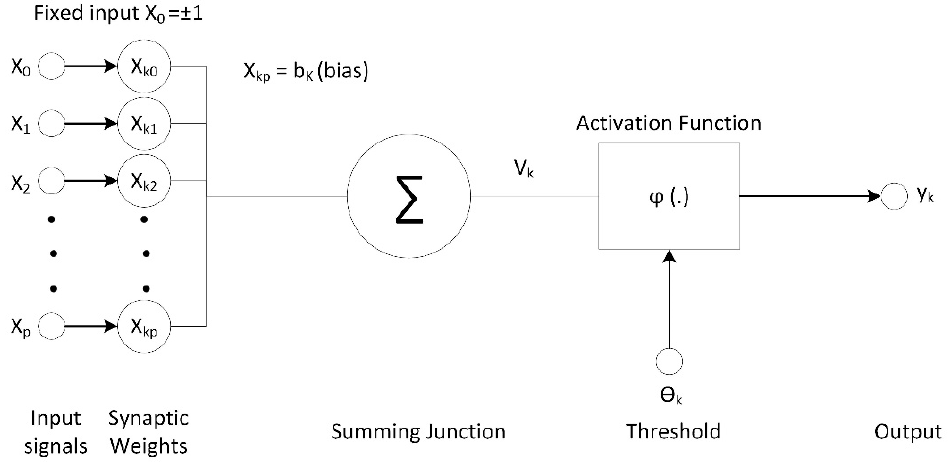
Figure 2. The block diagram shows the model of a neuron, which forms the basis for designing